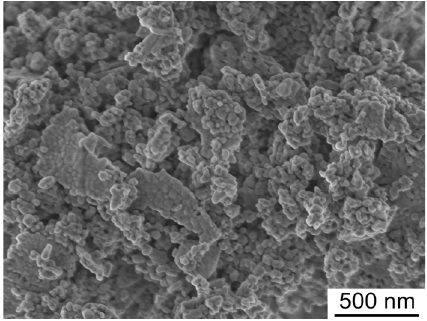
Fig. 7 SEM image of 0.93Y 2 O 3 ·0.005La 2 O 3 ·0.05Yb 2 O 3 · 0.015Zr 2 O 3 powder mixture after ball milling for 15